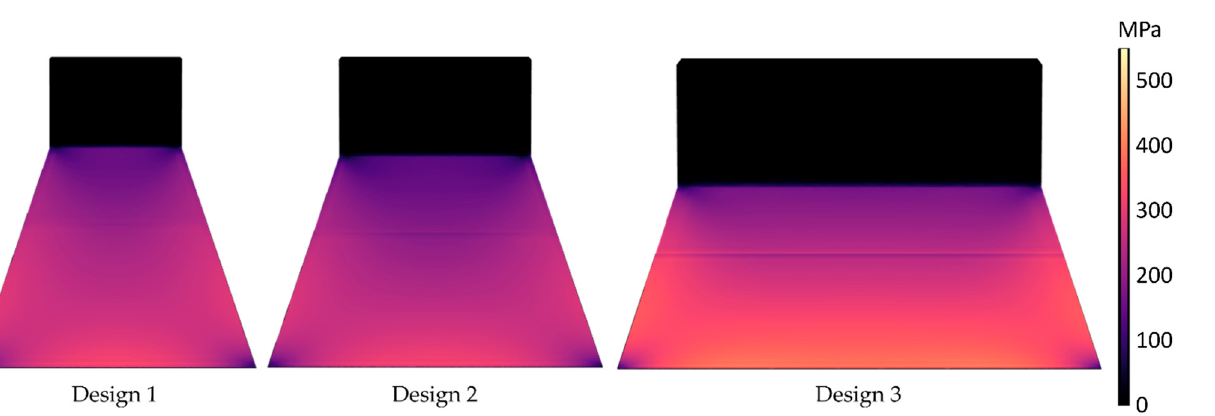
Figure 17. FEM simulated von Mises stress contour plots for the three harvester designs by applying a force (Figure 14d) at distance of 2 mm.